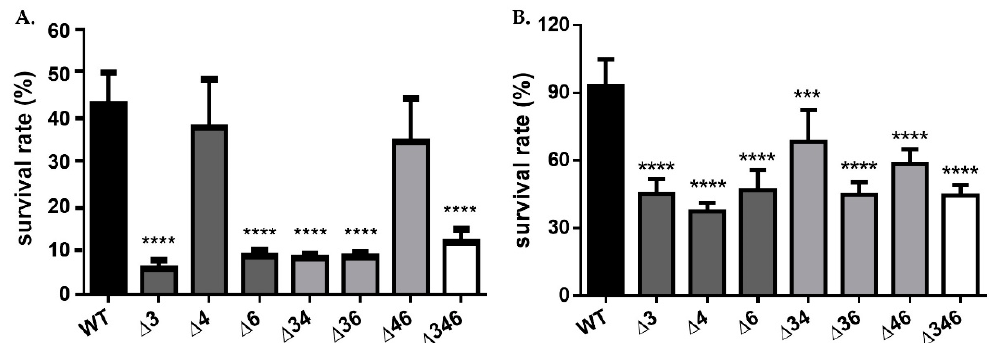
Figure 5. Survival rates of wild-type or mutant strains treated with ( A ) 5 mM H 2 O 2 ; or ( B ) 300 mM tert -BHP for 20 min. Two-way ANOVA tests were conducted to assess statistical significance. *** p < 0.001; **** p < 0.0001.